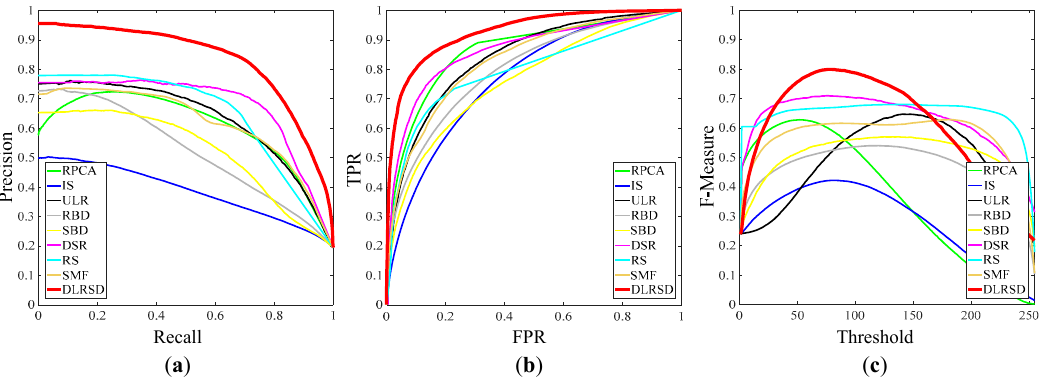
Figure 6. Quantitative comparisons: ( a ) precision-recall (P-R) curve; ( b ) receiver operating characteristic (ROC) curve; ( c ) F-measure curve.